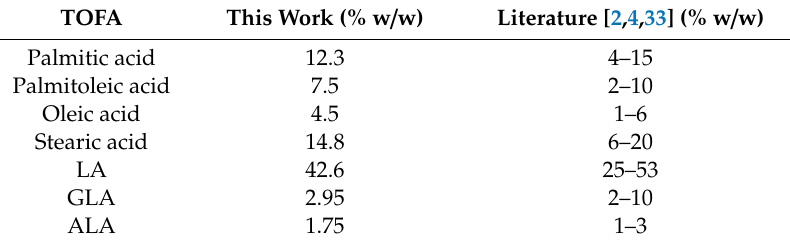
Table 3. HPLC RT of TOFAs before and after UC.